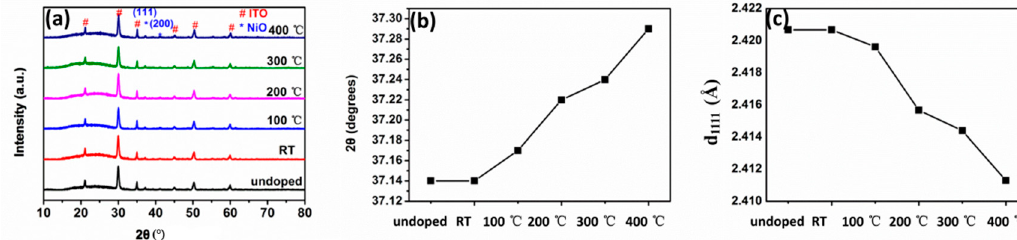
Figure 4. ( a ) XRD spectra of NiO thin films at di ff erent substrate temperatures and evolution of ( b ) angular position and ( c ) interplanar spacing of (111).